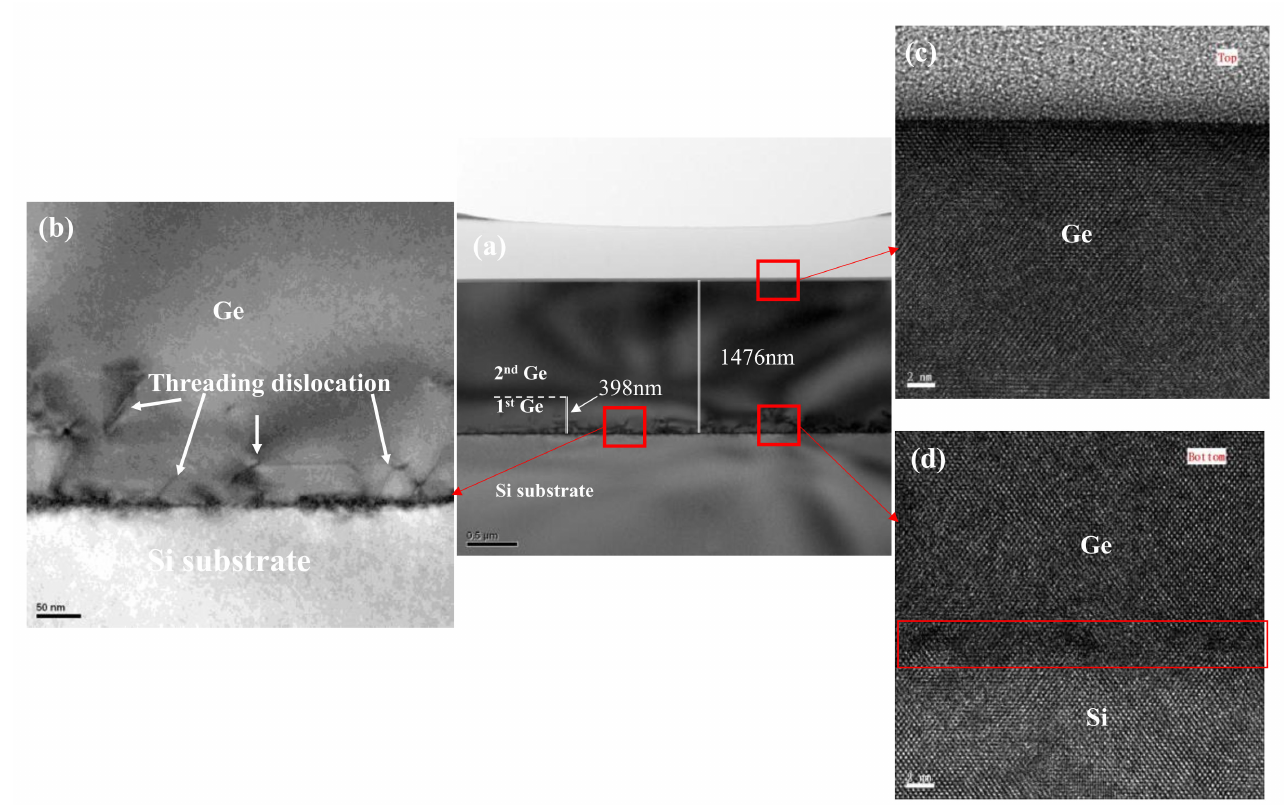
Figure 15. ( a ) Cross-sectional dark field TEM images of an optimized process of 1.4 µ m–thick Ge layer with the thickness of a 400 nm LT–buffer layer grown on a Si substrate; ( b ) high resolution TEM images of the first step Ge/Si interface of ( a ). Many threading dislocations appear at the interface of Ge/Si and disappear as the Ge buffer increases. HR-TEM images of two selected defects, the top Ge layer pointed out by an arrow in ( c ) and near the Ge/Si interface highlighted by red frame in ( d